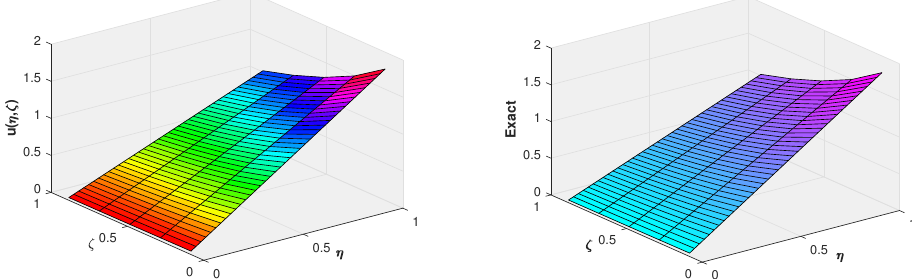
Figure 2. Three-dimensional comparison of the approximate and exact solution at k = 4, M = 5 of Example 1.